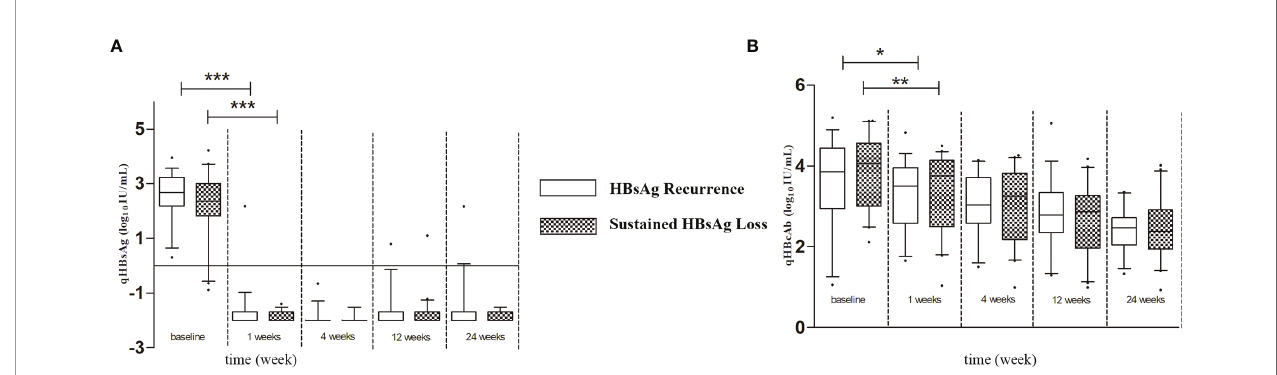
FIGURE 1 | (A) The Kinetics of qHBsAg in HBsAg recurrence and sustained HBsAg loss groups. (B) The Kinetics of qHBcAb in HBsAg recurrence and sustained HBsAg loss groups. Box plots showing the median, interquartile range and absolute range of qHBcAb and qHBsAg at baseline and at 1 week, 4 weeks, 12 weeks and 24 weeks in groups (blank box plots: HBsAg recurrence group; latticed box: sustained HBsAg loss group. * p <0.05; ** p <0.01; *** p <0.001).